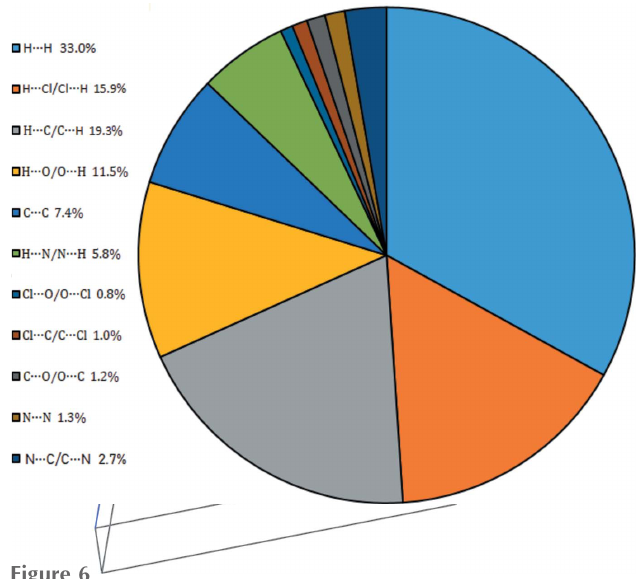
Figure 6 All interactions with percentage